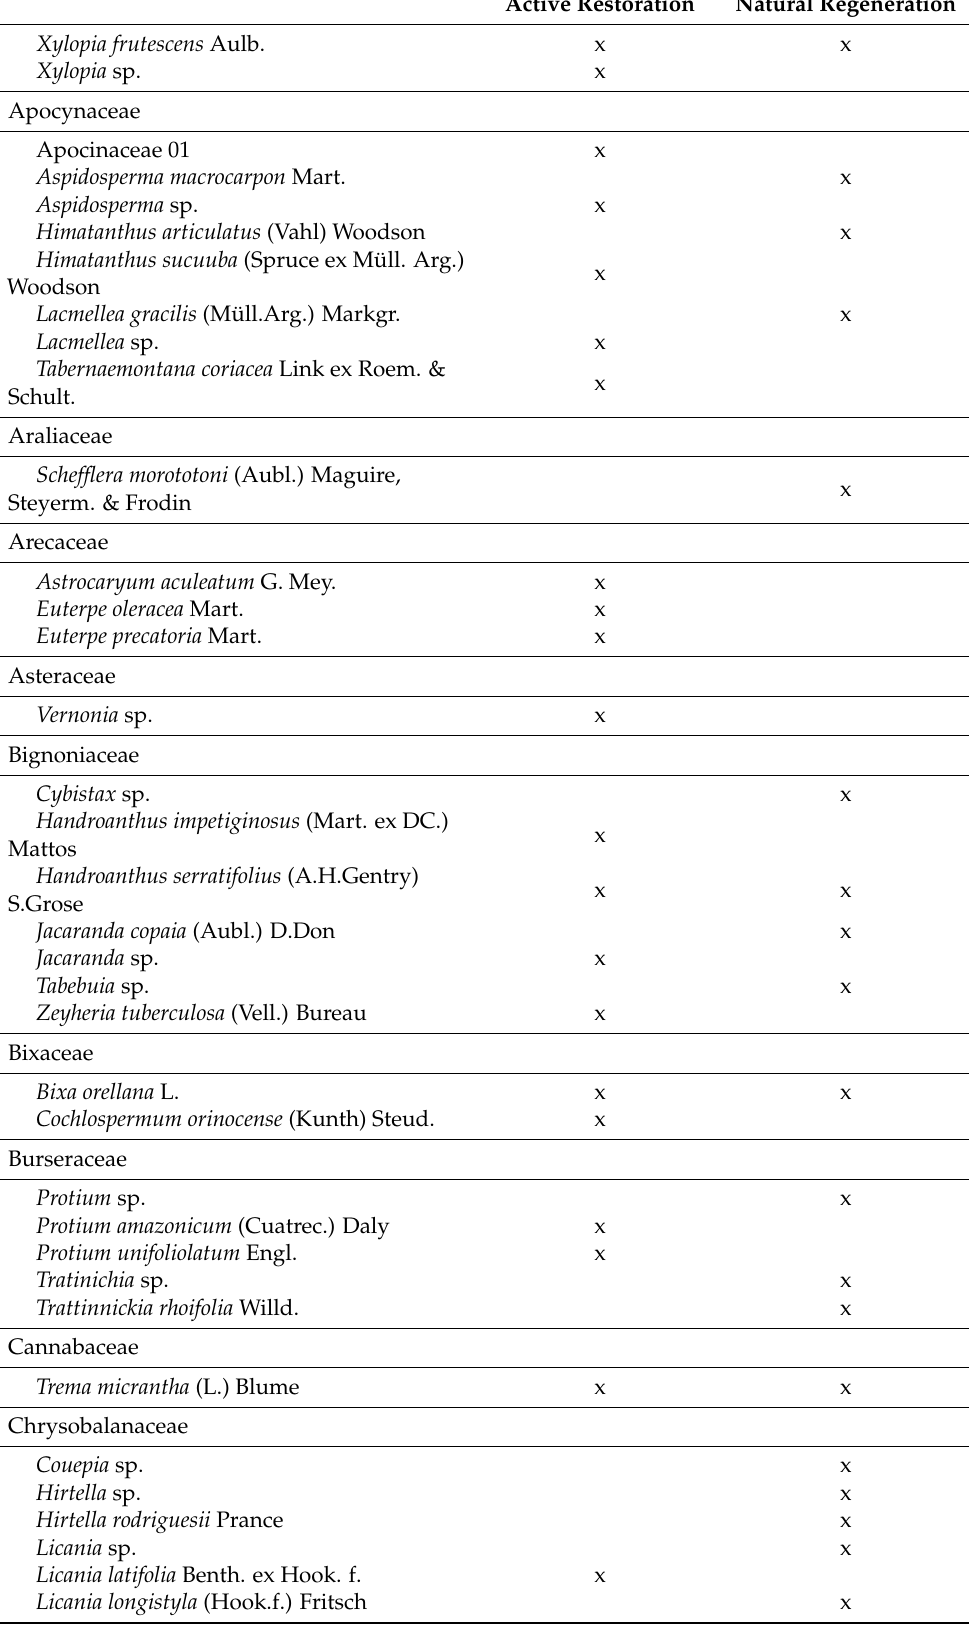
Active Restoration Natural Regeneration